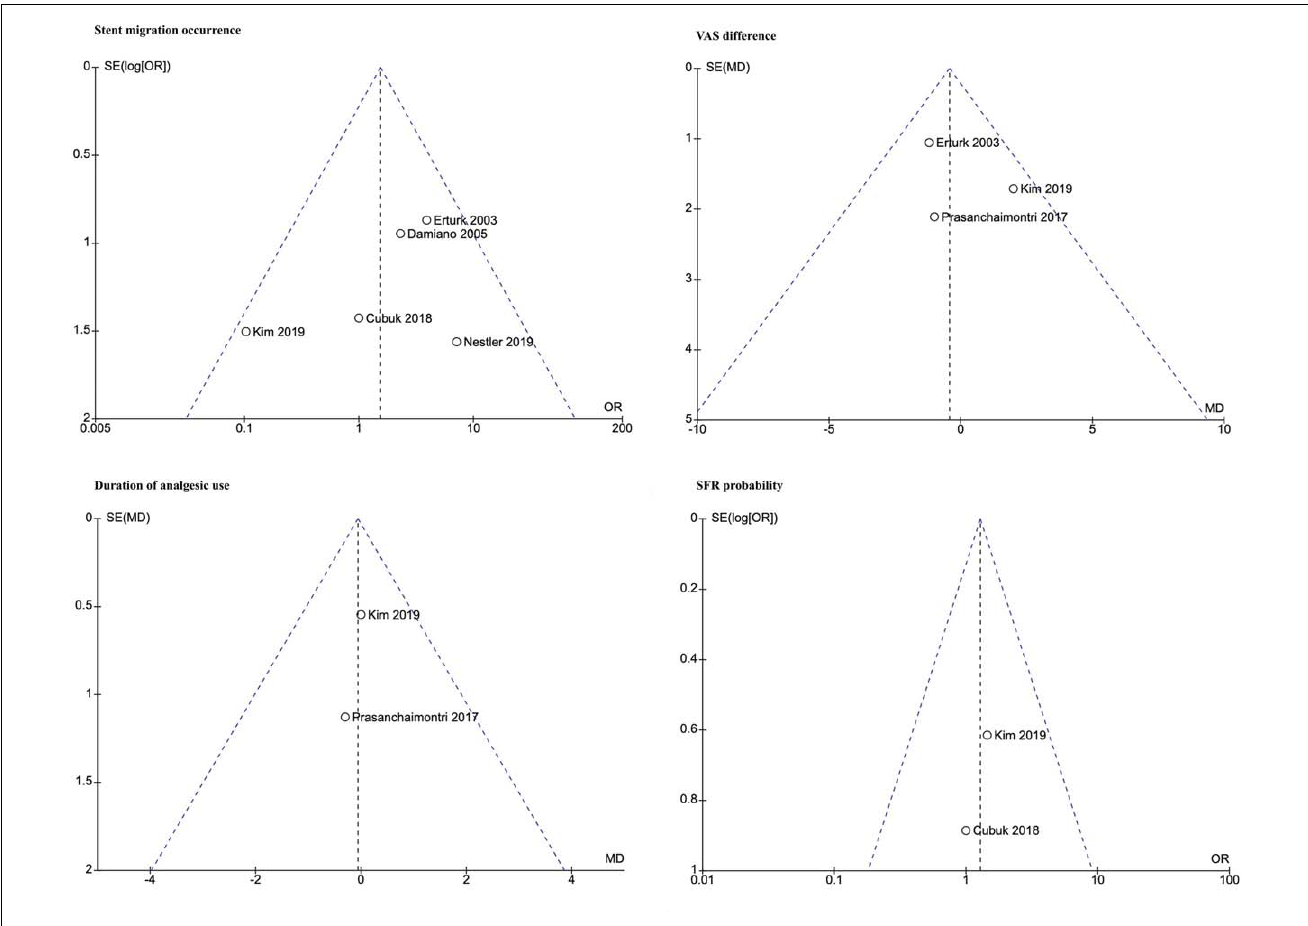
Figure 3. Funnel plot of studies reporting stent migration occurrence, VAS, duration of analgesic use, and SFR